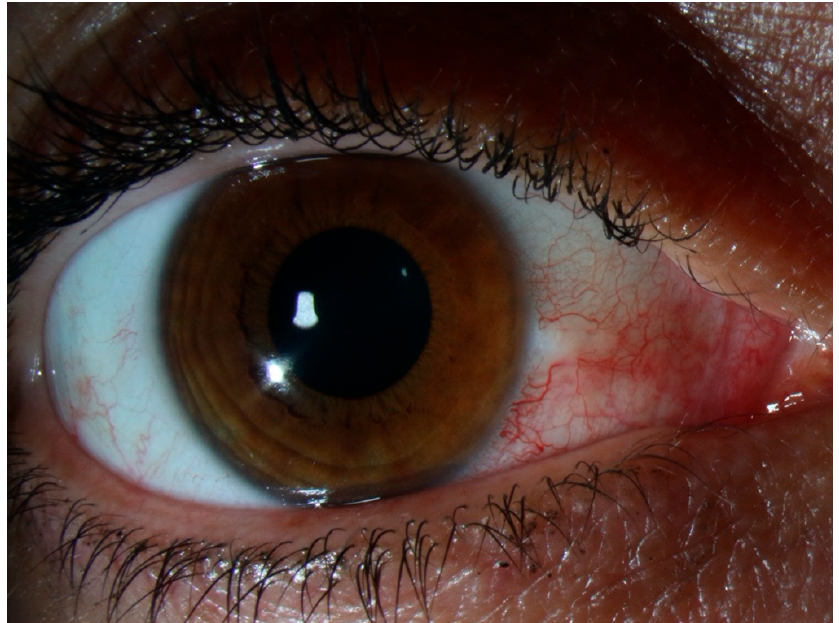
Figure 2. Episcleritis. There is no scleral swelling, and although the deep vascular plexus is congested, oedema and infiltration are limited to the episclera. The eye redness is most often limited to one sector of the eye, with a salmon pink to red discoloration. The pain is generally mild.